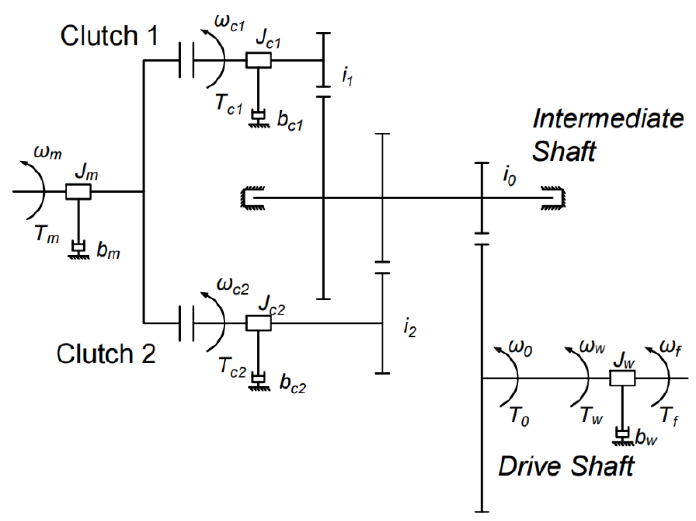
Figure 5. 2DCT transmission structure schematic diagram.